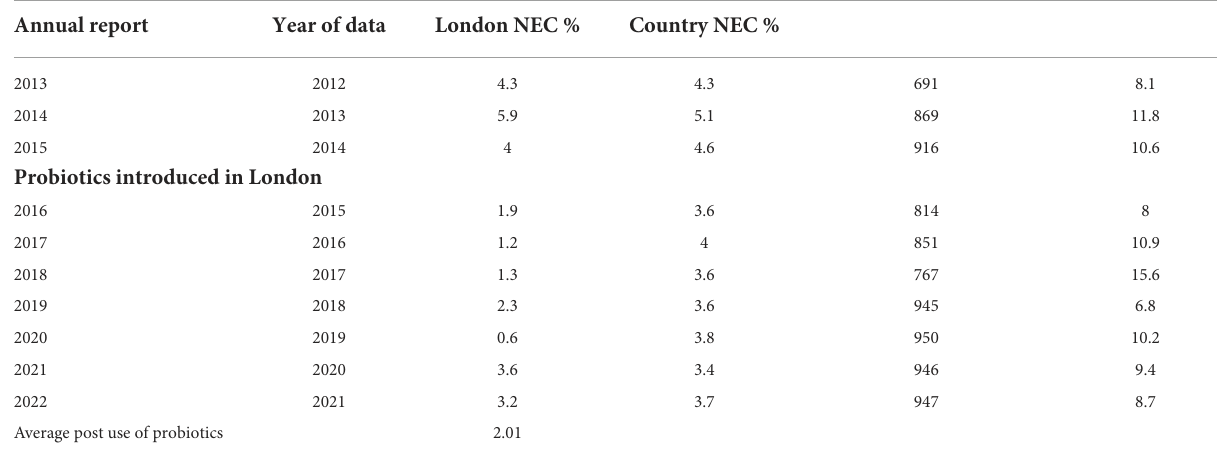
TABLE 3 Data from the Canadian Neonatal Network (CNN). Infants < 33